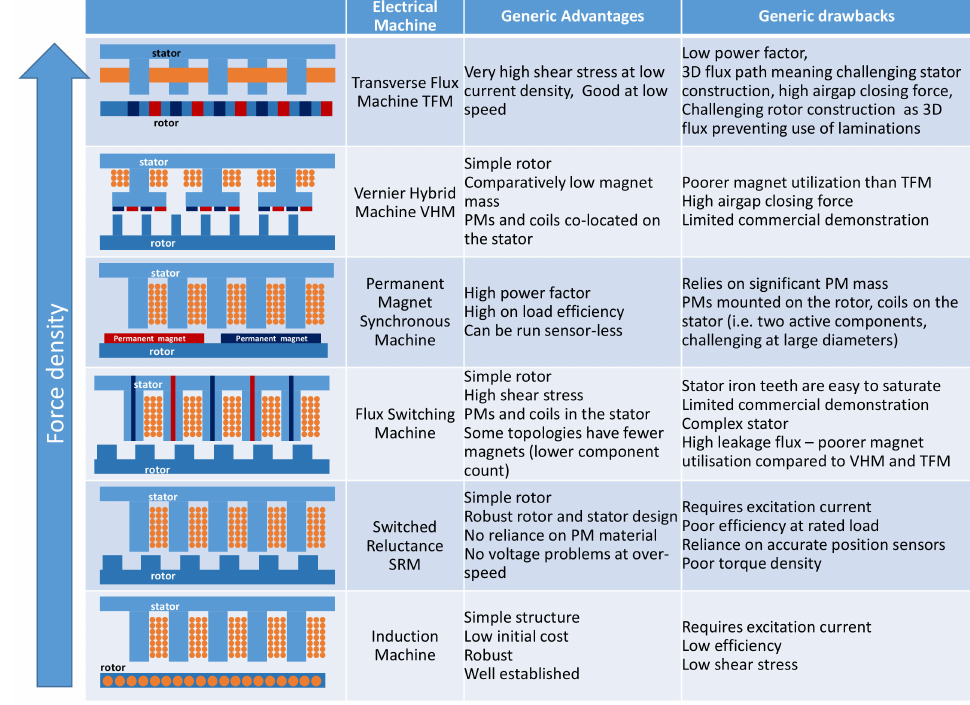
Figure 2. Electrical machine topology comparison for use as power take-off in a wave energy